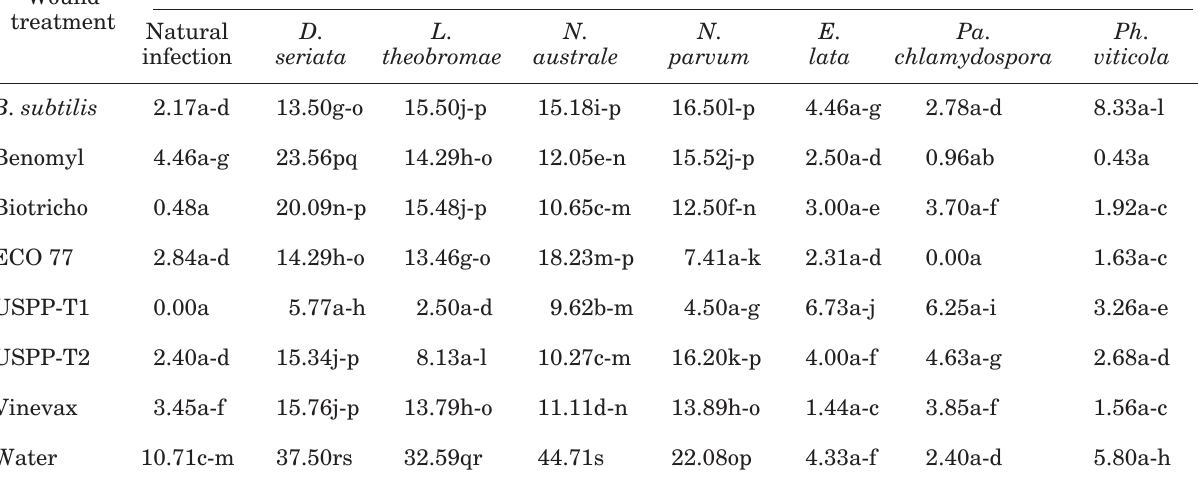
Table 4. Mean combined incidence of species of Botryosphaeriaceae that were isolated from pruning wounds 8 months after the fresh pruning wounds were treated with benomyl, Bacillus subtilis , two Trichoderma spp. (USPP-T1 and -T2), three commercial Trichoderma -based biocontrol products or water as pruning wound protectants, and chal- lenged 7 days later by spray-inoculation with Eutypa lata , Phaeomoniella chlamydospora , Phomopsis viticola , Di- plodia seriata , Lasiodiplodia theobromae , Neofusicoccum australe and N. parvum spore suspensions, or sprayed with sterile water to evaluate natural